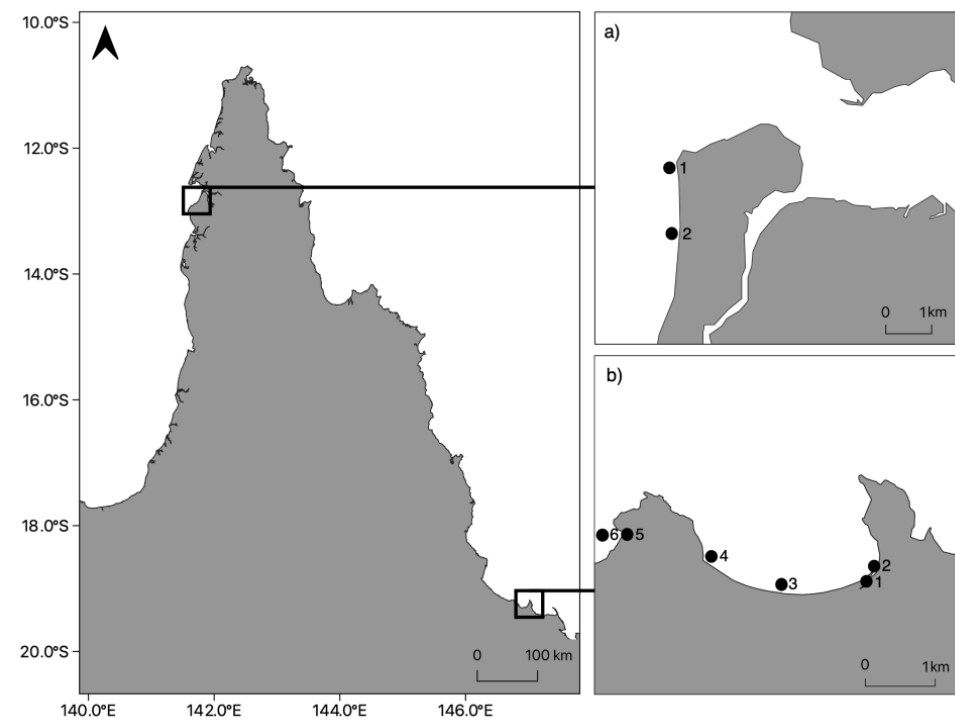
Figure 2. Map displaying in situ sampling sites (black dots—numbered to identify sample site) located at Weipa, Queensland ( a ) and Horseshoe Bay, Magnetic Island ( b ) for in situ validation.